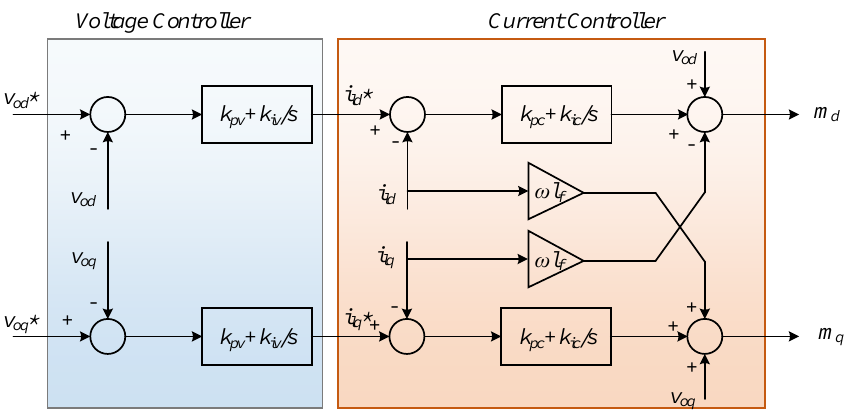
Figure 3. Control scheme of inner controller.